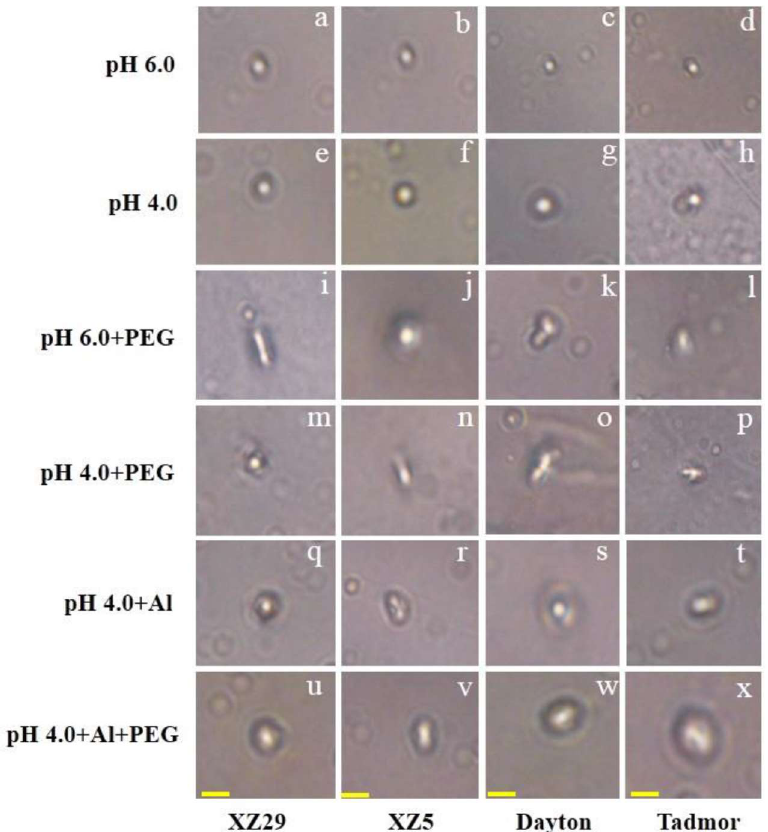
Figure 6. DNA damage analyses of leaves in of Tibetan wild barley XZ29 (left panel), XZ5 (left middle) and cv. Dayton (right middle), Tadmor (right panel) grown under pH 6.0 (a, b, c, d), pH 4.0 (e, f, g, h), pH 6.0+PEG (i, j, k, l), pH 4.0+PEG (m, n, o, p), pH 4.0+Al (q, r, s, t) and pH 4.0+Al+PEG (u, v, w, x) stresses, respectively, for seven days. Images were taken using a fluorescence microscope (BX50WI; Olympus, Shinjuku, Tokyo, Japan) equipped with a digital charge-coupled device (CCD) camera (Olympus). Bar = 40 µ